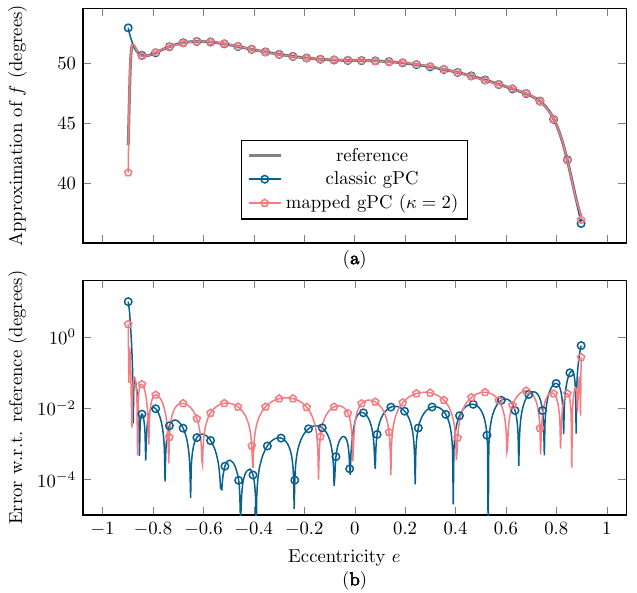
Figure 13. ( a ) The approximation of f using classic and mapped gPC and ( b ) the error on the ap- proximation with regard to the reference curve, with w ( x ) = Beta ( x ;2,2 ) and N = 15. The reference curve was constructed by sampling the full